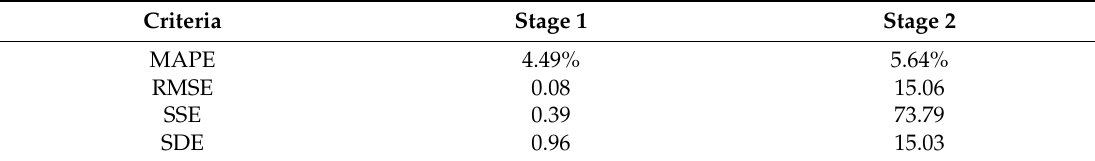
Table 2. Accuracy Analysis of the Proposed Method—Fall Day.